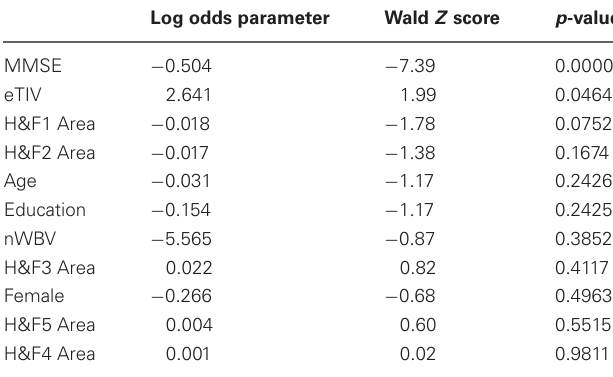
Table 6 | Ordinal logistic regression parameter values and significance values ( Z and p -values) for predicting the Clinical Dementia Rating (CDR) scores in 191 older subjects within the OASIS